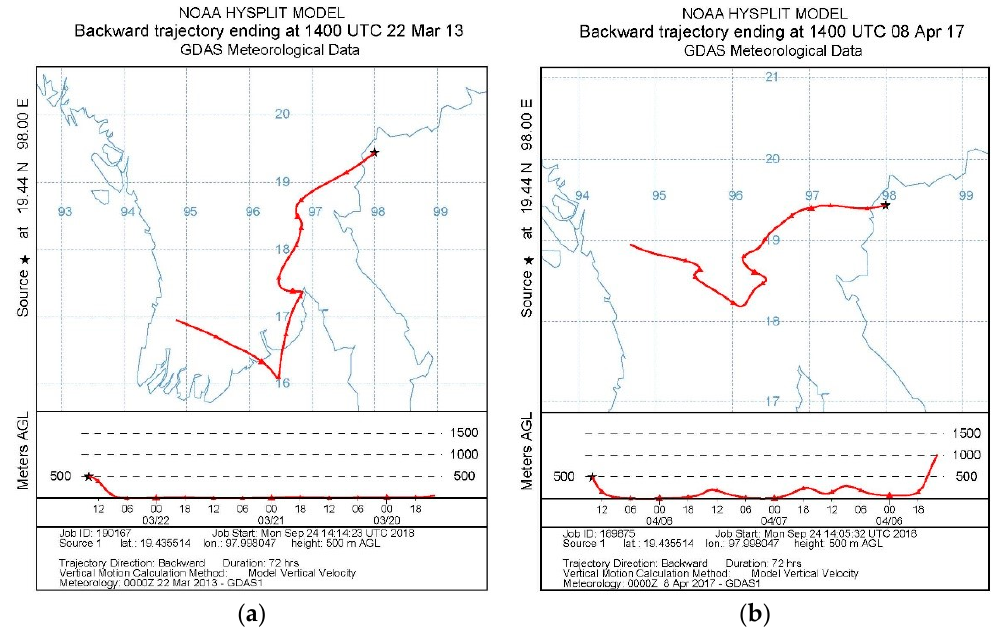
Figure 9. Calculated back trajectories for the 72 h period starting 24 March 2013 ( a ) and ending 8 April 2017 ( b ) at Mae Hong Son Pollution Control Department (PCD) Monitoring Station.